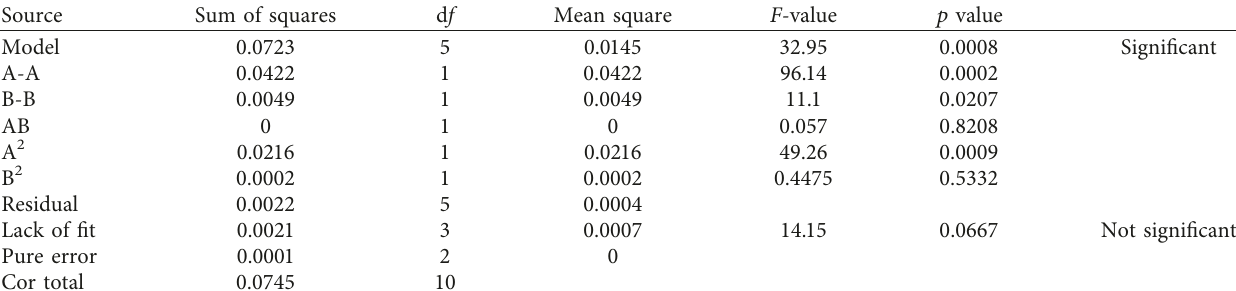
Table 5: Estimated coefficients of multiple determinations ( R 2 ) for stability using coded values.